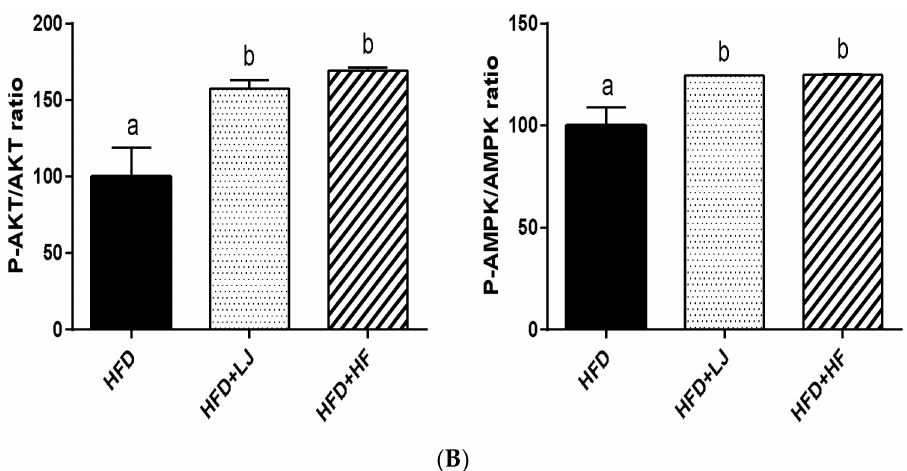
Figure 5. Effects of LJ and HF on the activation of Akt and AMPK in skeletal muscle from mice fed a high-fat diet (HFD) for 16 weeks. Data are represented as the mean ± SEM ( n = 5). ( A ) Representative immunoblot analysis of phosphorylation and total Akt and AMPK; ( B ) Quantitative results of ( A ). a,b : Values that do not share the same superscript are significantly different by ANOVA ( p < 0.05).